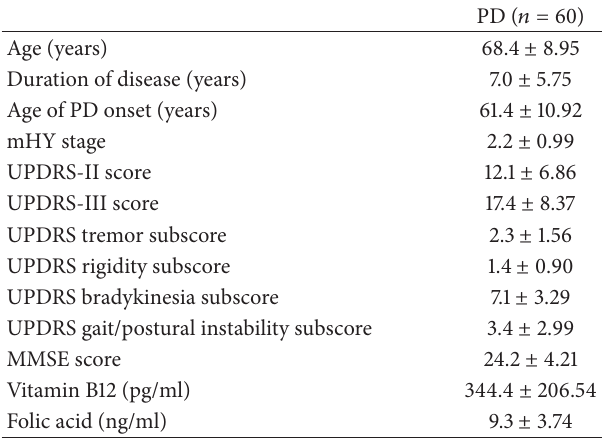
Table 1: Demographic and clinical characteristics and values of vitamin B12 and folic acid in PD patients ∗